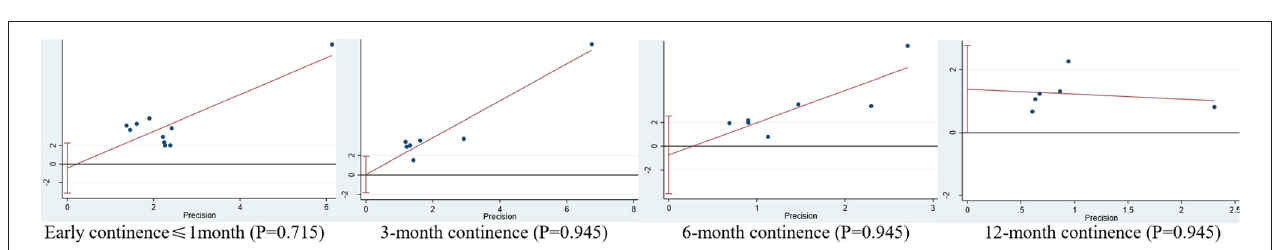
FIGURE 12 | Publication